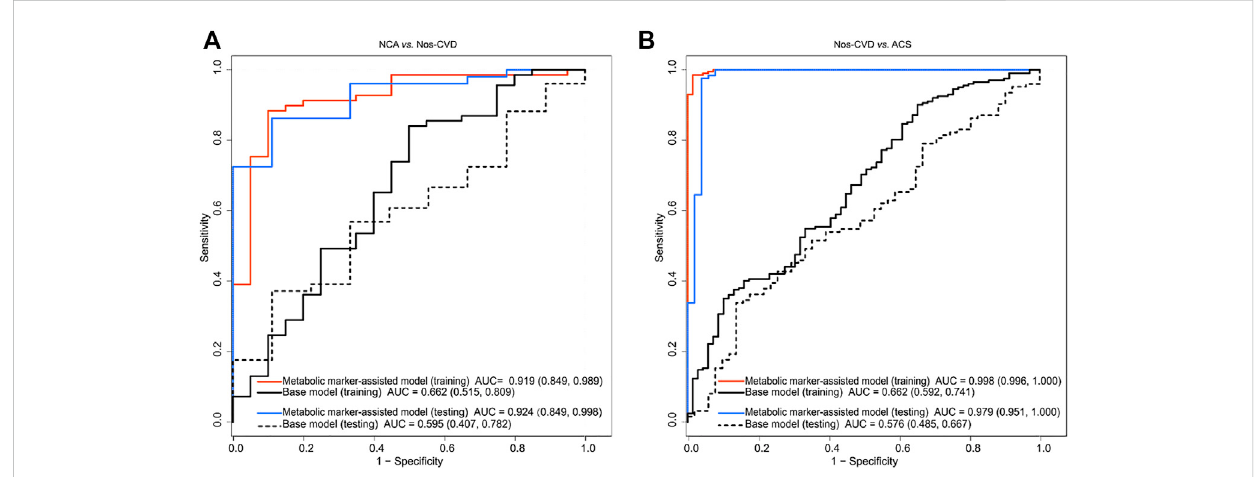
FIGURE 3 Receiver operating characteristic (ROC) curve analyses of base models and metabolic merker-assisted models (A) Area under the curve (AUC) for discriminating normal coronary artery (NCA) from non-signi fi cant cardiovascular diseases (nos-CVDs) (B) AUC estimation for discriminating nos-CVDs from acute coronary syndrome